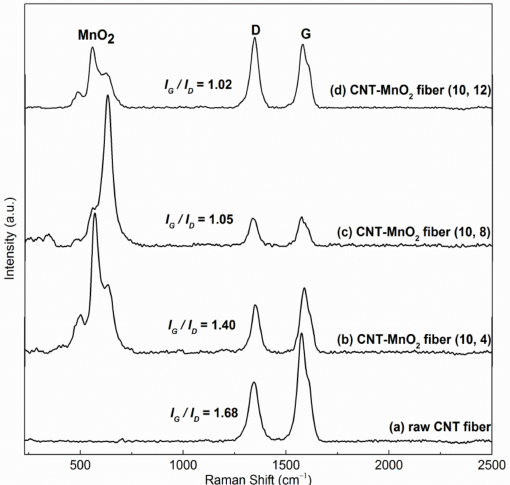
Figure 5. Raman spectra of ( a ) raw CNT fiber and ( b ) CNT–MnO 2 fibers (10, 4), ( c ) (10, 8), and ( d ) (10,